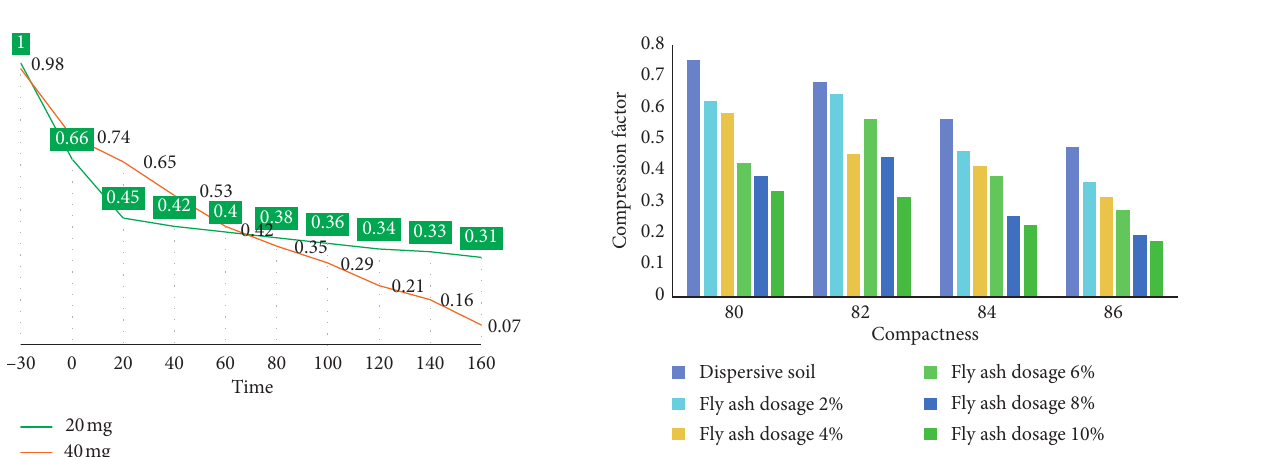
Figure 3: Degradation rate curve of methylene blue with different qualities of nanomontmorillonite modified fly ash under visible light.